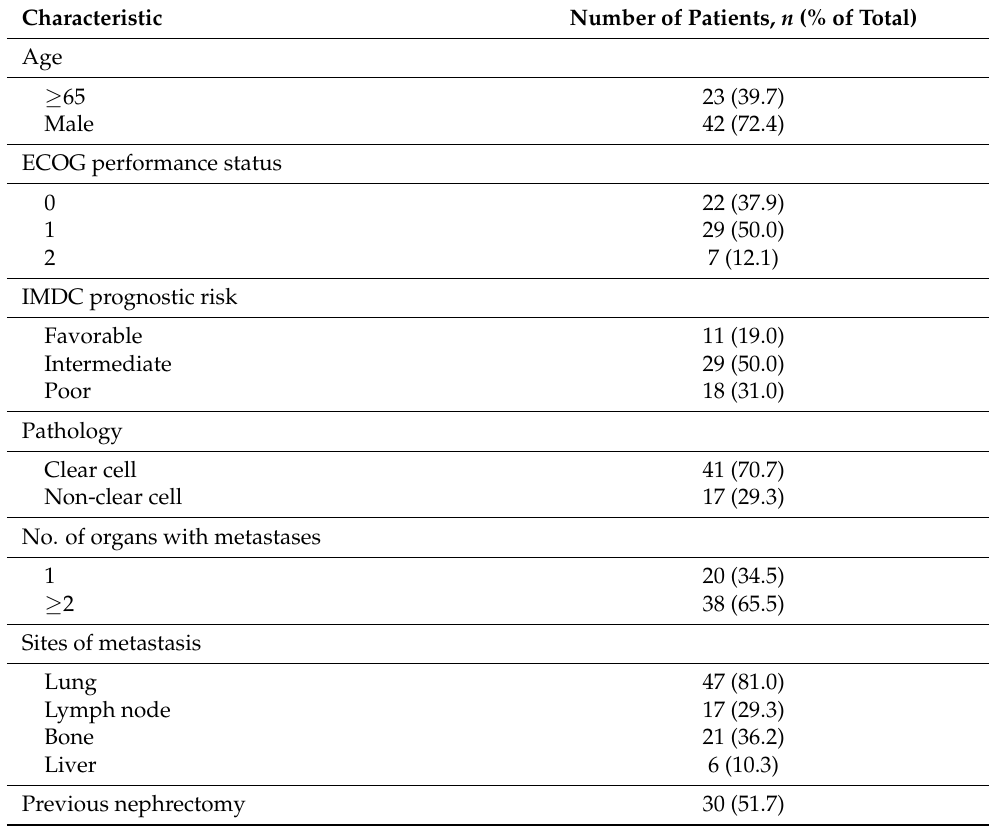
Table 1. Demographics and disease characteristics at